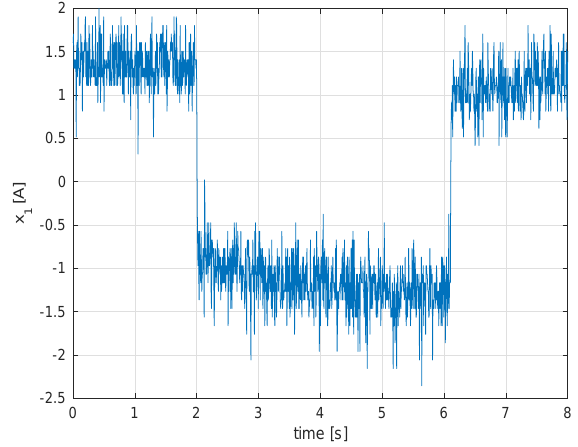
Figure 19. Experimental Result: Inductor current.